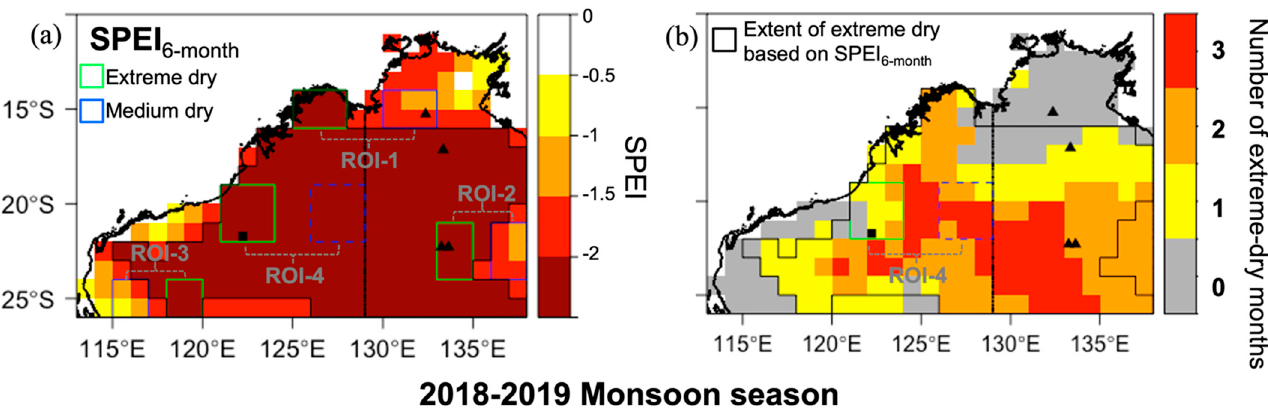
Figure 3. ( a ) Spatial pattern of drought intensity based on SPEI 6-month during 2018–2019 monsoon season. ( b ) Pixel-wise number of extreme-dry months based on SPEI 1-month . Four pairs of ROIs are shown in Figure 3a. The black boundary represents the extent of extreme (within) and medium (outside) dry.